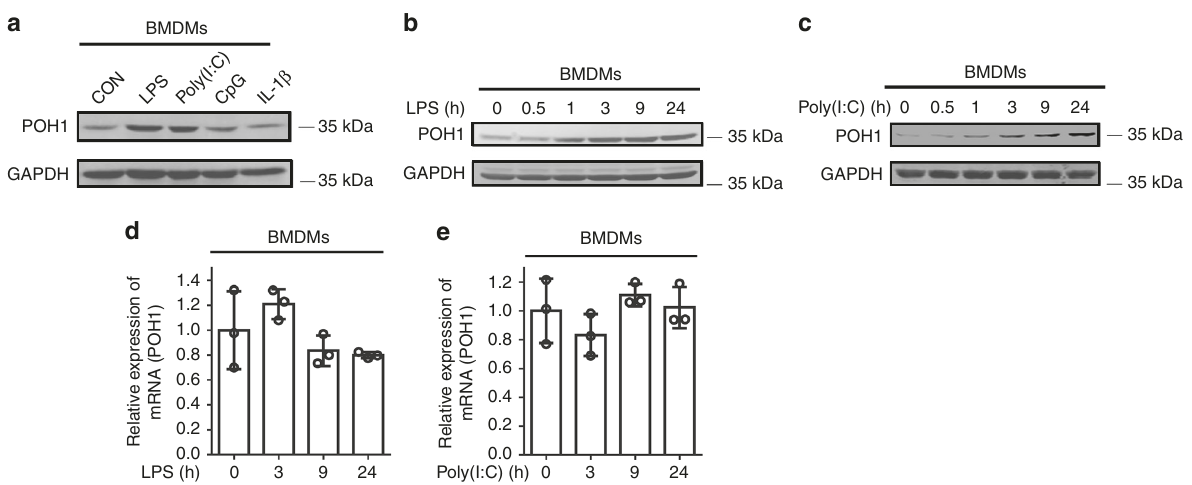
Fig. 2 POH1 expression is upregulated in macrophages by TLR3/4 activation. a BMDMs from WT mice were stimulated with LPS (100 ng/mL), poly(I:C) (10 μ g/mL), CpG (5 μ M) or IL-1 β (10 ng/mL) for 9 h and analysed for expression of POH1 by immunoblot. b, c Immunoblot analysis of POH1 expression from BMDMs treated with b LPS or ( c ) poly(I:C) as indicated. d, e RT-PCR analysis of POH1 expression in BMDMs in response to d LPS or e poly(I:C) stimulation. Similar results were obtained from three independent experiments. The results represent the mean ± s.d. of three independent sets of